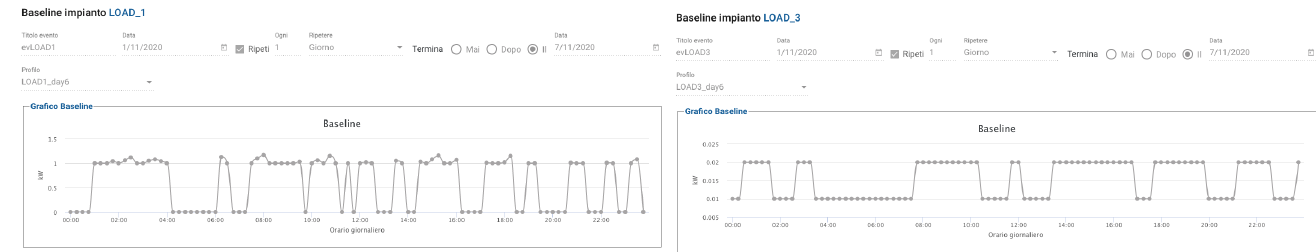
Figure 16. ( right ) Baseline for LOAD1 setting. ( left ) Baseline for LOAD3